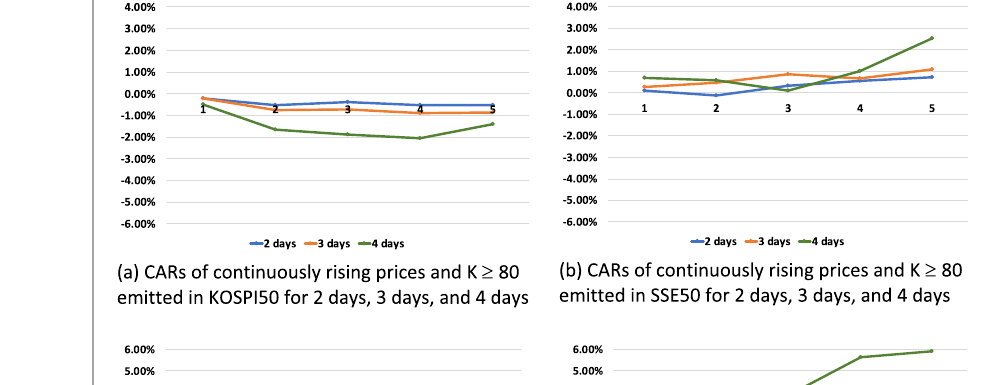
Fig. 2 CARs of continuously rising K